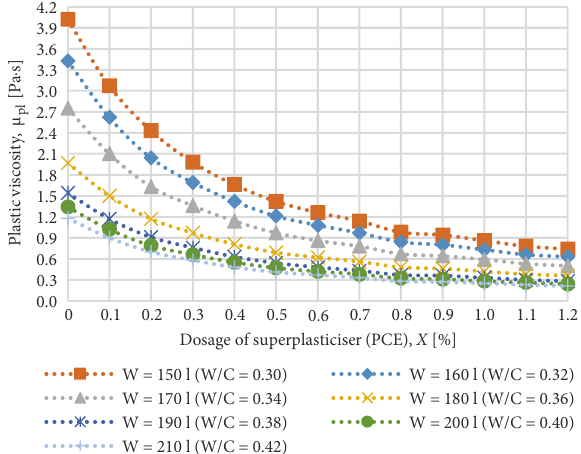
Figure 7. Dependence of the plastic viscosity of the plasticised pastes on the dosage of plasticising admixtures (PCE) in different water content (the ratio of